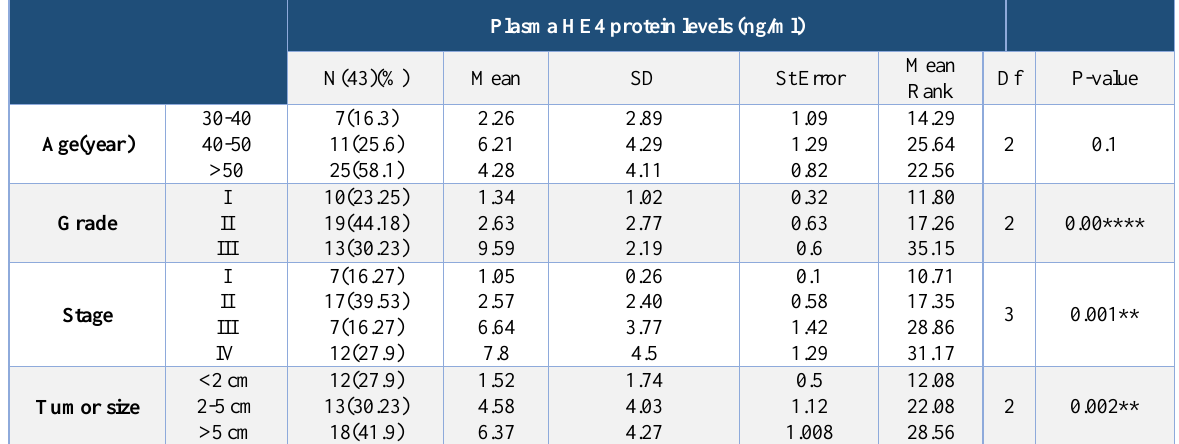
Table 3. Association between plasma HE4 expression in BC patients and clinicopathological features. Results of Kruskal-Wallis non- parametric test.